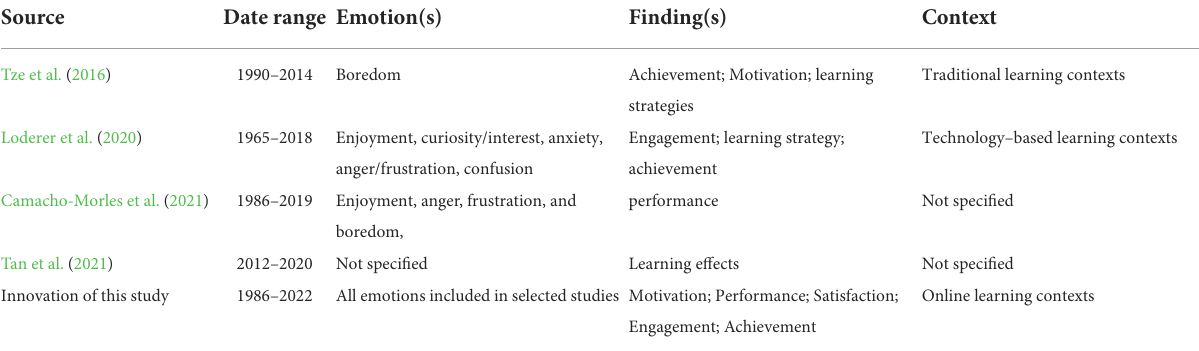
TABLE 2 Previous reviews of achievement